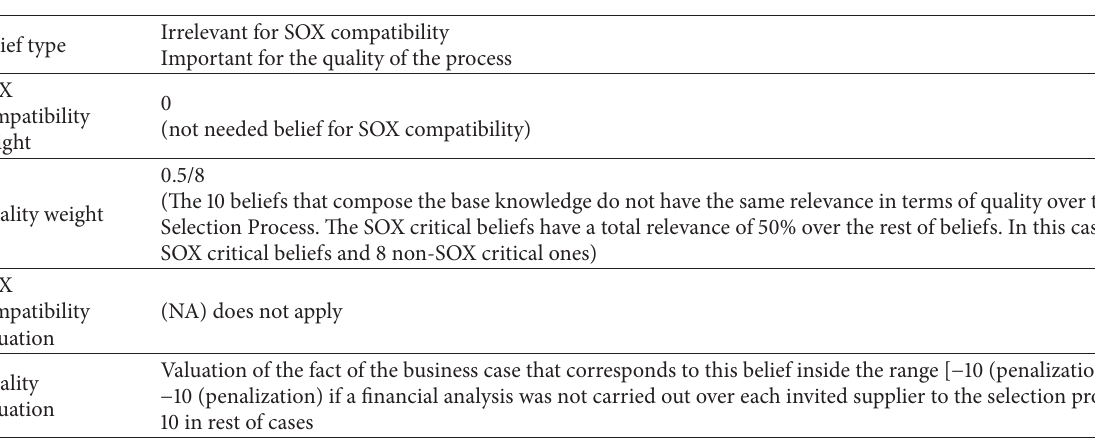
Table 5: Financial Analysis Scoring Protocol.